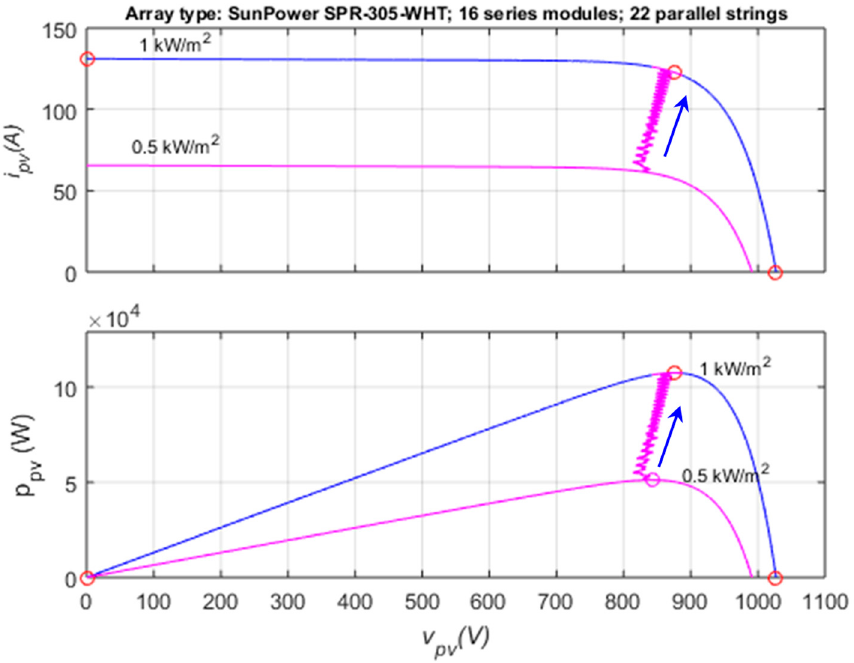
Figure 11. Effects of a 50% irradiance transient of PV power vs. PV voltage in case of irradiance ramp decrease.